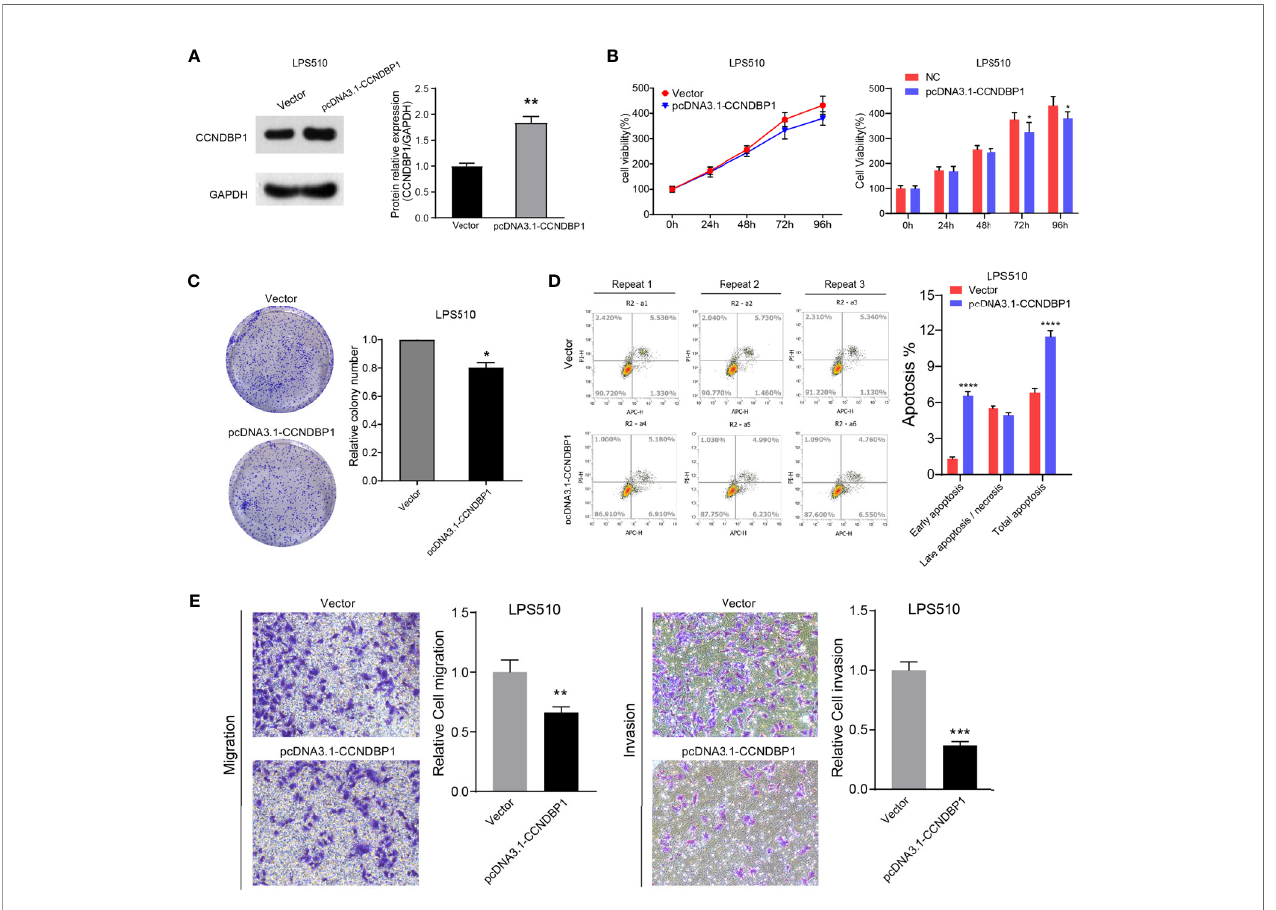
FIGURE 5 | Overexpression of CCNDBP1 could signi fi cantly inhabit the clone formation, proliferation, migration, and invasion capacities of LPS510, and could accelerate cell apoptosis. (A) Compared with the vector group, CCNDBP1 protein expression level increased after transfected pcDNA3.1-CCNDBP1, and the difference had a statistical signi fi cance; (B) CCK8 experiment veri fi ed that the cell proliferation capacity was inhibited after CCNDBP1 overexpression in LPS510 and a signi fi cant difference occurred from the 72 h; (C) Clone formation experiment veri fi ed that the clone formation capacity was inhibited after CCNDBP1 overexpression in LPS510; (D) The total apoptosis rate of LPS510 cells in the pcDNA3.1-CCNDBP1 group was declined in comparison with the vector group, and the difference between the two groups had a statistical signi fi cance, mainly because of the increase of the early apoptosis cells; (E) The migration and invasion capacities of LPS510 in the pcDNA3.1-CCNDBP1 group were inhibited in comparison with the vector group; *P < 0.05; **P < 0.01; ***P < 0.001; ****P <